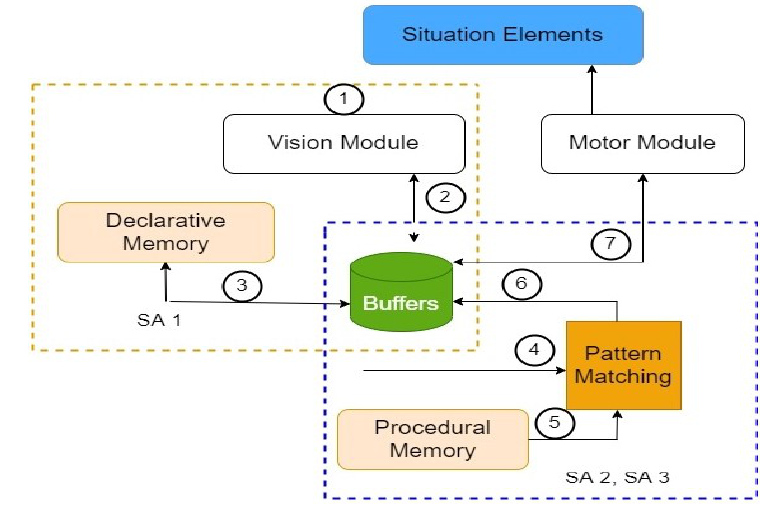
Figure 2. Overall architecture of the situation awareness in the